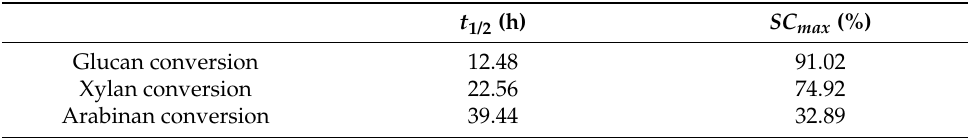
Table 5. Parameters of kinetic enzymatic model using the extract MD. t 1/2 (h) SC max (%) Glucan conversion 12.48 91.02 Xylan conversion 22.56 74.92 Arabinan conversion 39.44 32.89